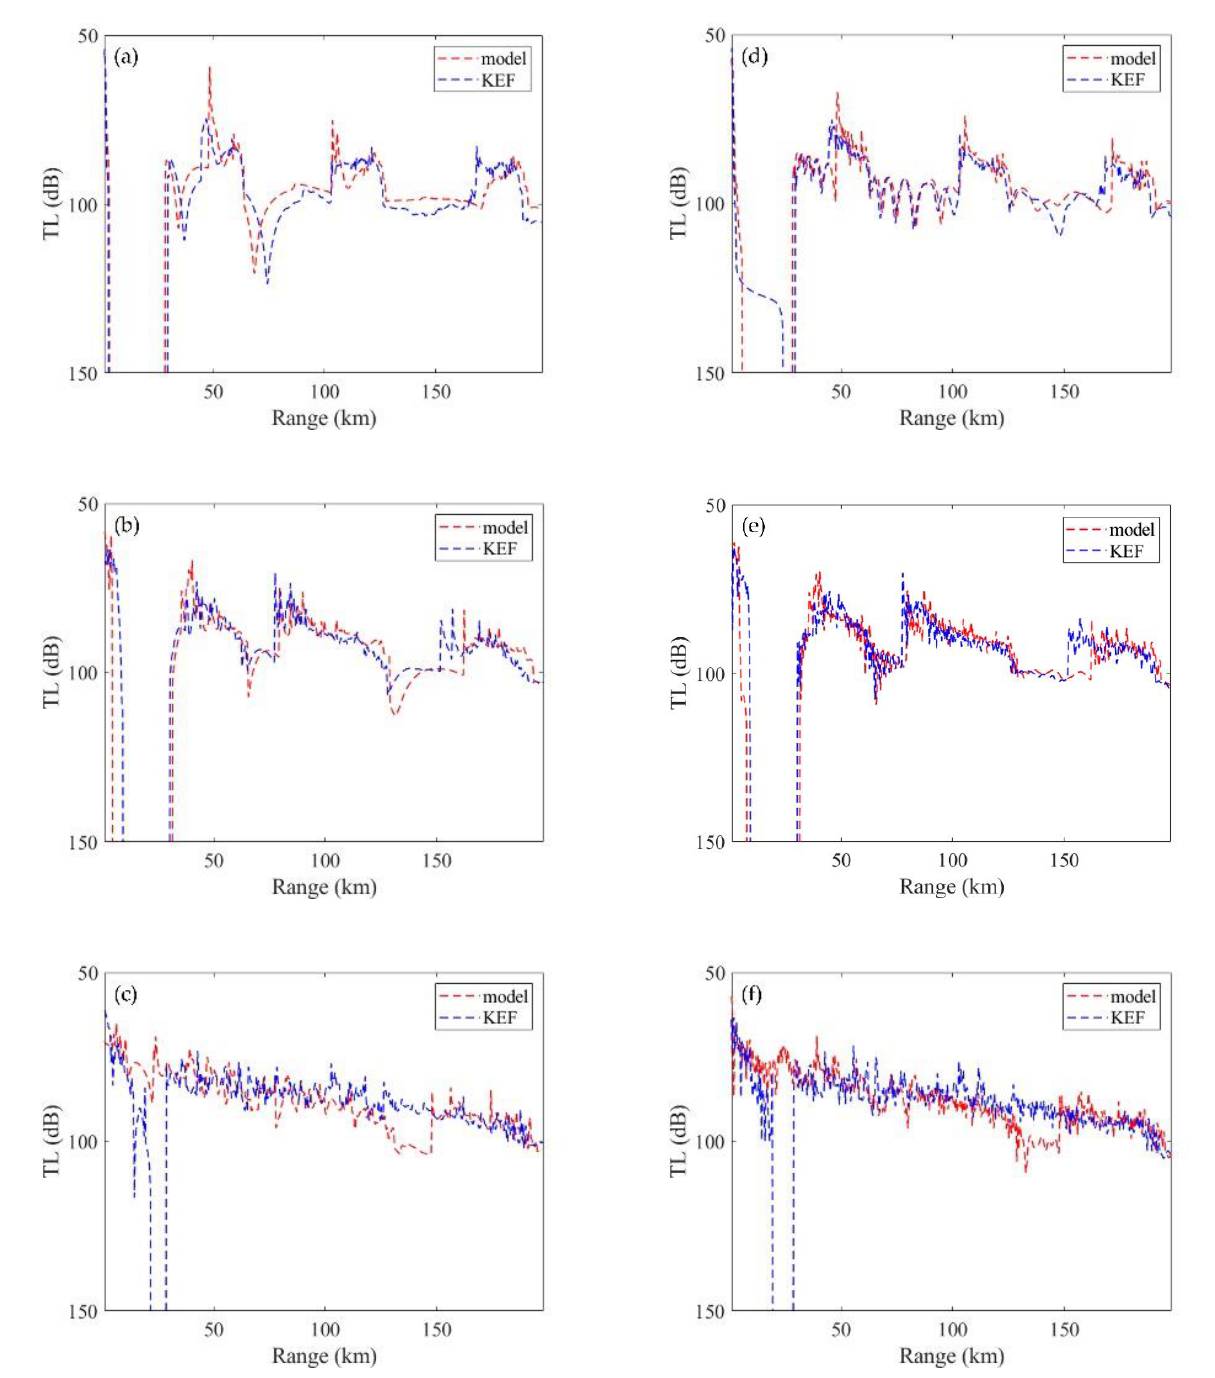
Figure 11. Comparison of the model and actual TL under different SD and frequency on 1 July: ( a ) f = 50 Hz, SD = 100 m; ( b ) f = 50 Hz, SD = 300 m; ( c ) f = 50 Hz, SD = 500 m; ( d ) f = 400 Hz, SD = 100 m; ( e ) f = 400 Hz, SD = 300 m; ( f ) f = 400 Hz, SD = 500 m. When the SD was 100 m, the difference between the TL calculated by the model and the TL calculated by the actual ocean front was very small at low and high frequencies. At 300 m, in terms of the overall distribution trend, the results of the model were similar to the calculation results under the actual ocean front environment. At 500 m, in terms of the overall trend, the results of the model and the actual results also showed many similarities.